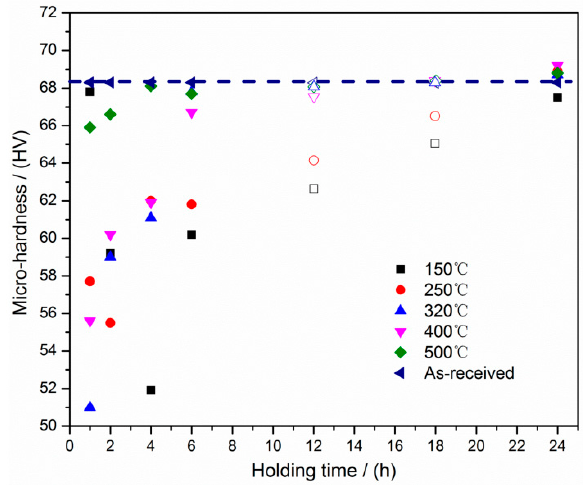
Figure 6. Micro-hardness evolution of the foams.